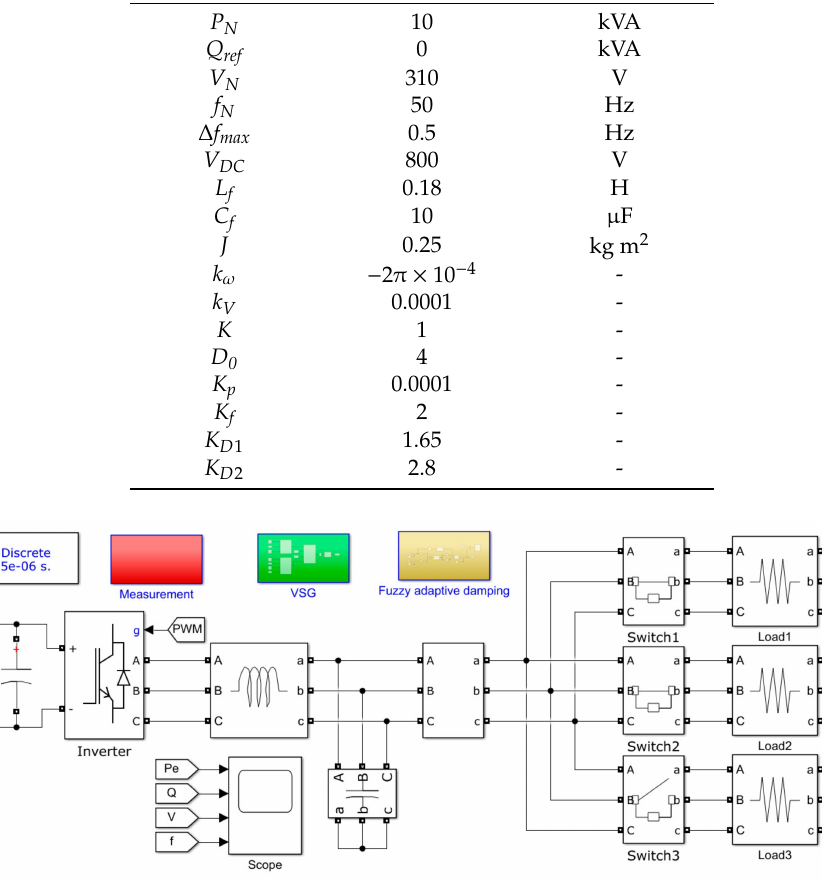
Figure 10. Structure of the proposed fuzzy adaptive damping based VSG in